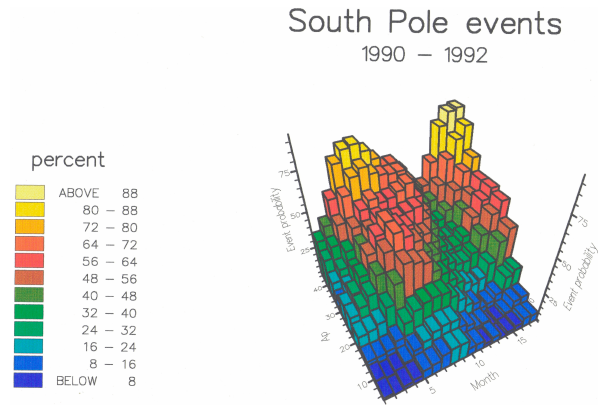
Fig. 3. Probability of at least one absorption event occurring per day at South Pole as functions of month and A p . The first six months are repeated after month 12 (December). Figure 4: Dependence of event occurrence on Ap